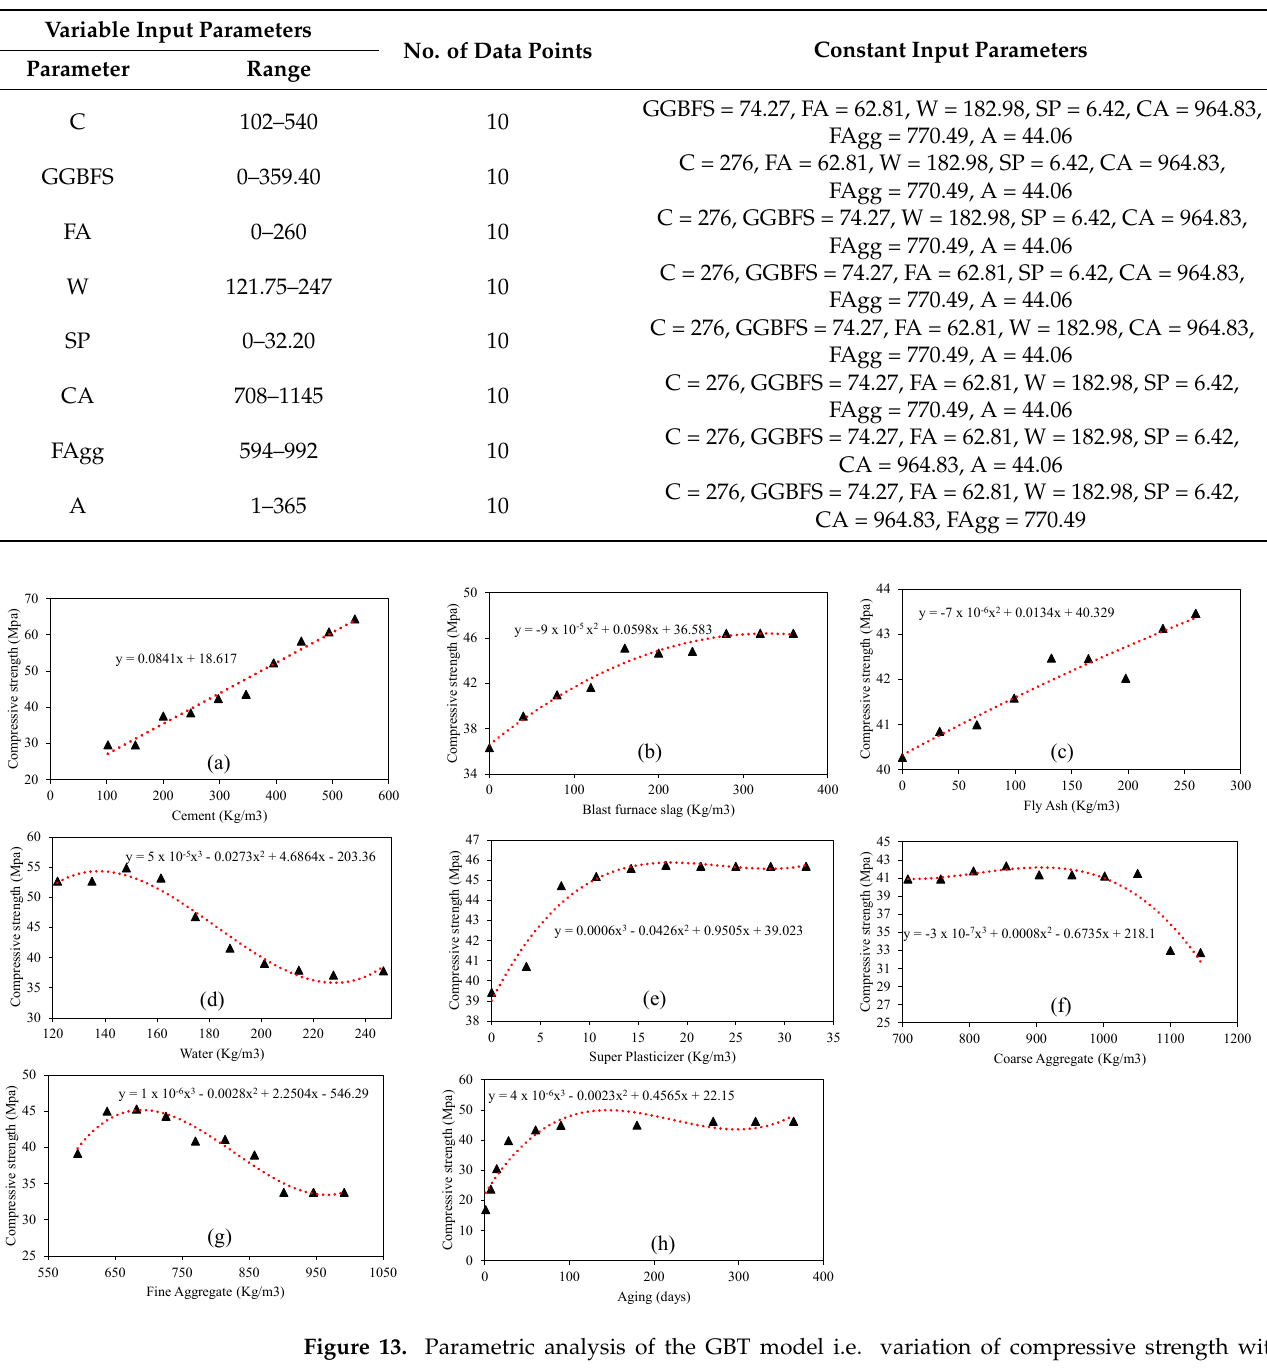
Table 8. Simulated dataset for parametric and sensitivity analysis.